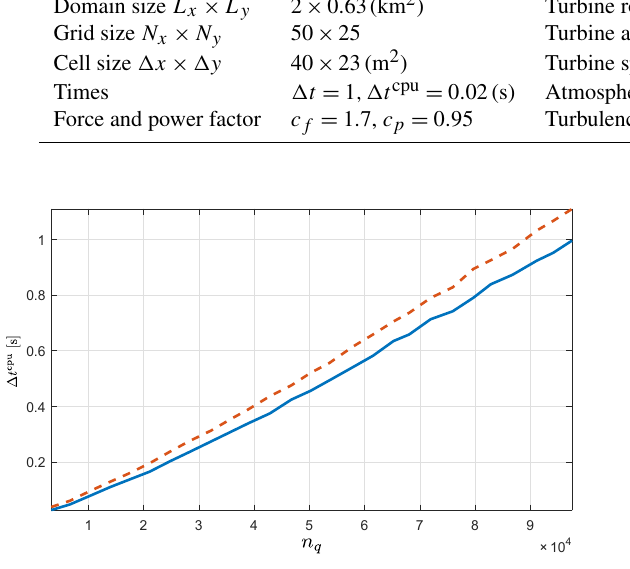
Figure 7. Mean computation time per simulation time step (cid:49)t cpu vs. number of states n q . The red dashed line is WFSim as presented in Eq. (20) and blue is WFSim as presented in Eq. (21). Note that the number of cells is approximately n q / 3 with n q the number of